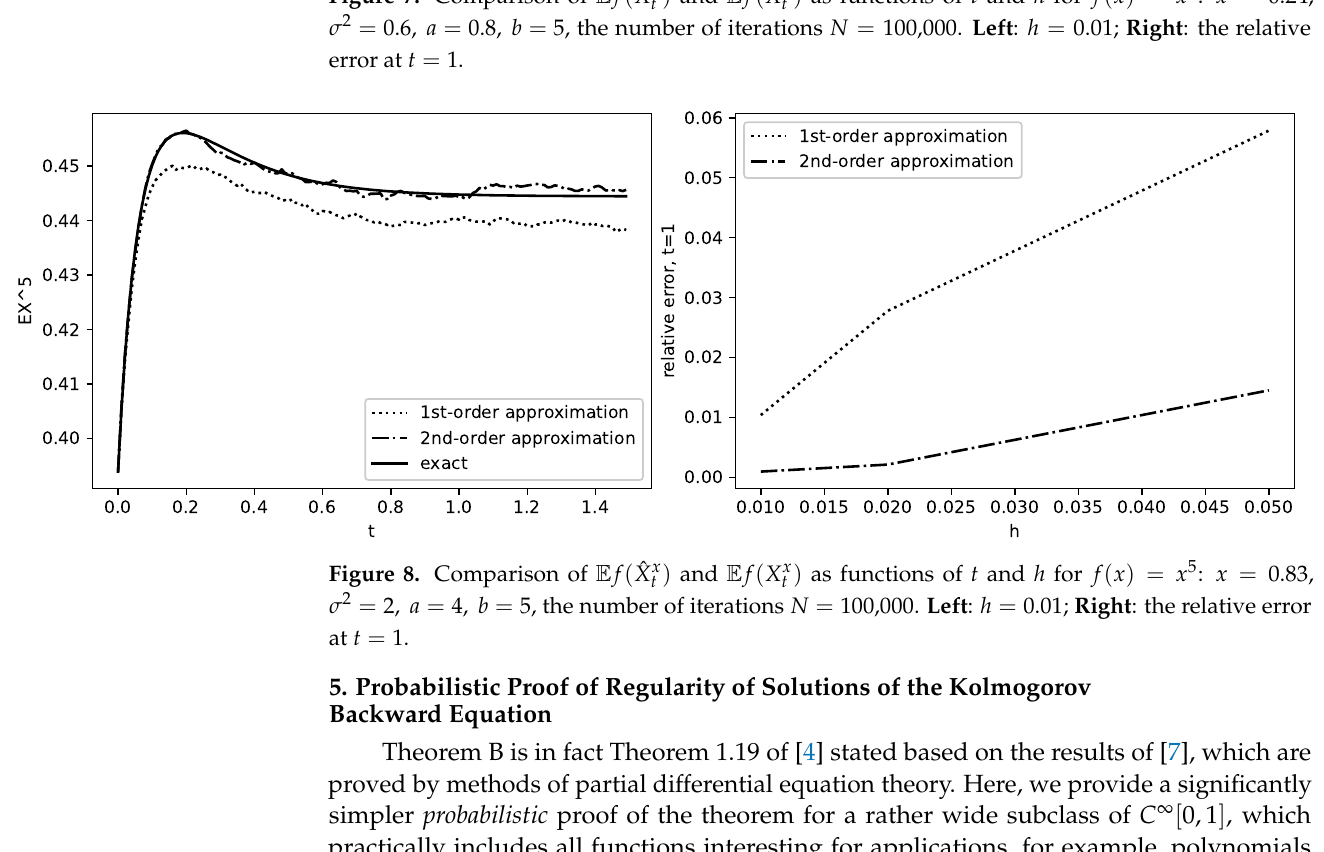
) and E f ( X x ) as functions of t and h for f ( x ) = x 5 : x = 0.24, t t